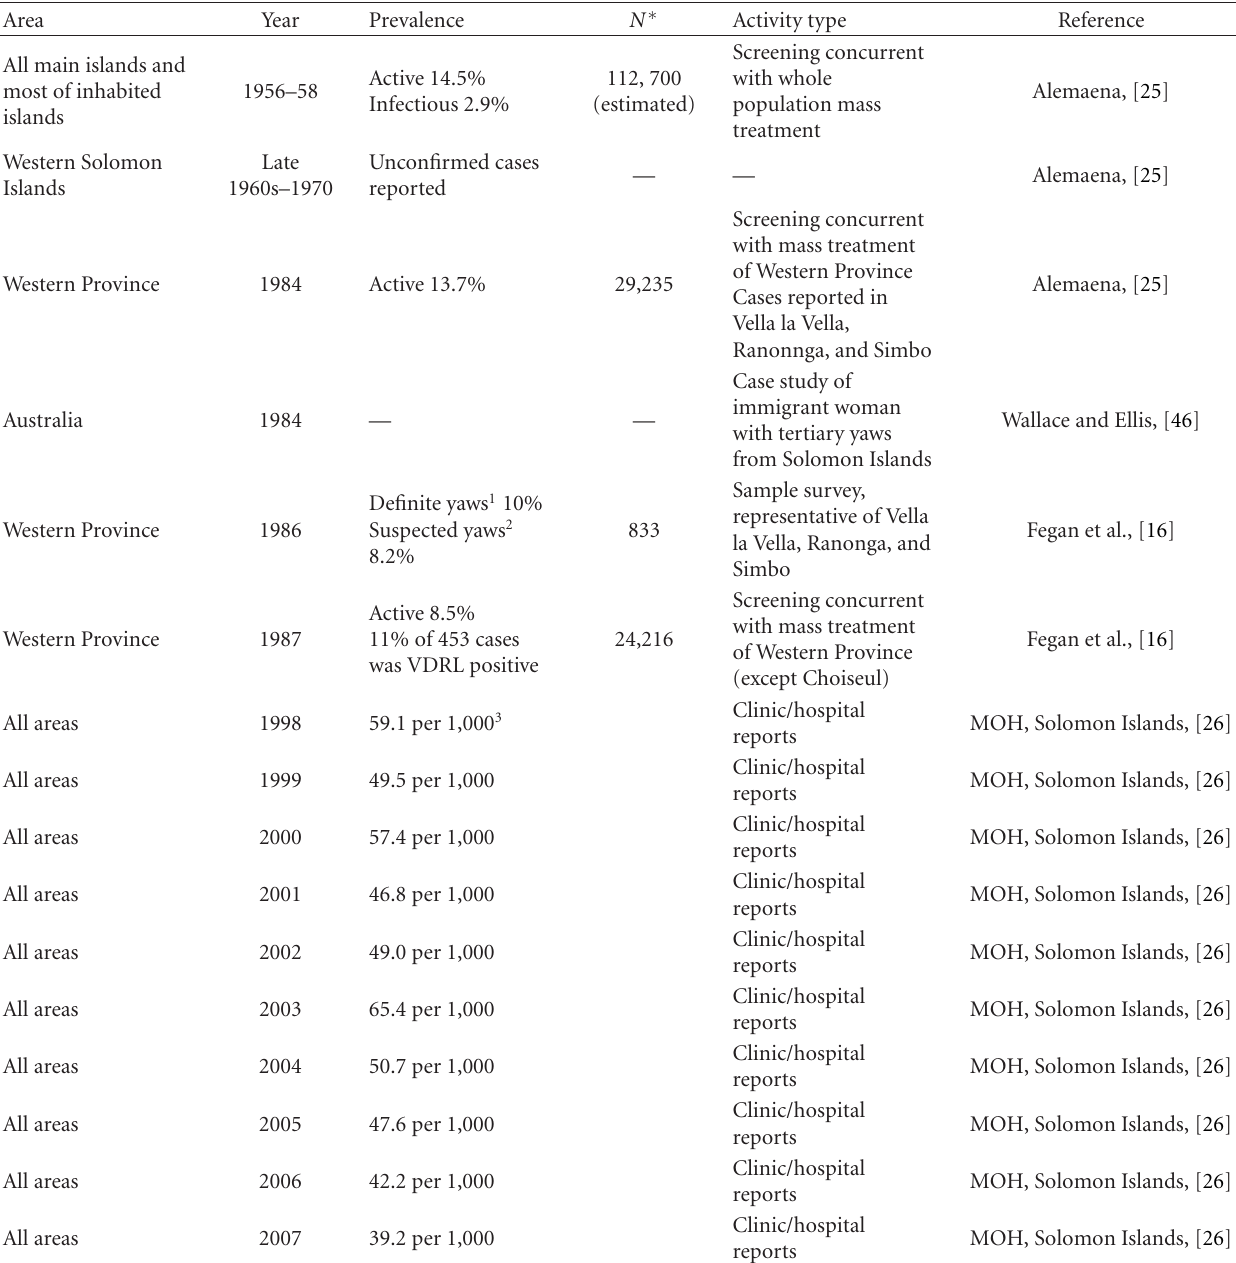
Table 4: Summary of yaws reported cases and prevalence surveys in Solomon Islands since